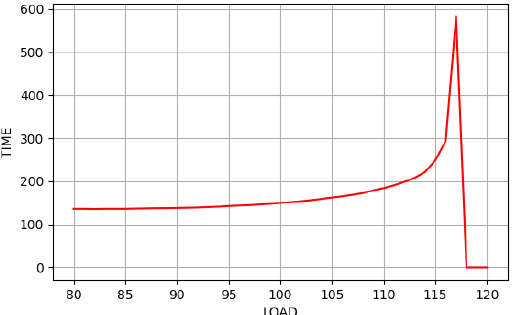
Figure 8. The curve of load rate–time of returning to a stable state when the SVG compensator is the same.